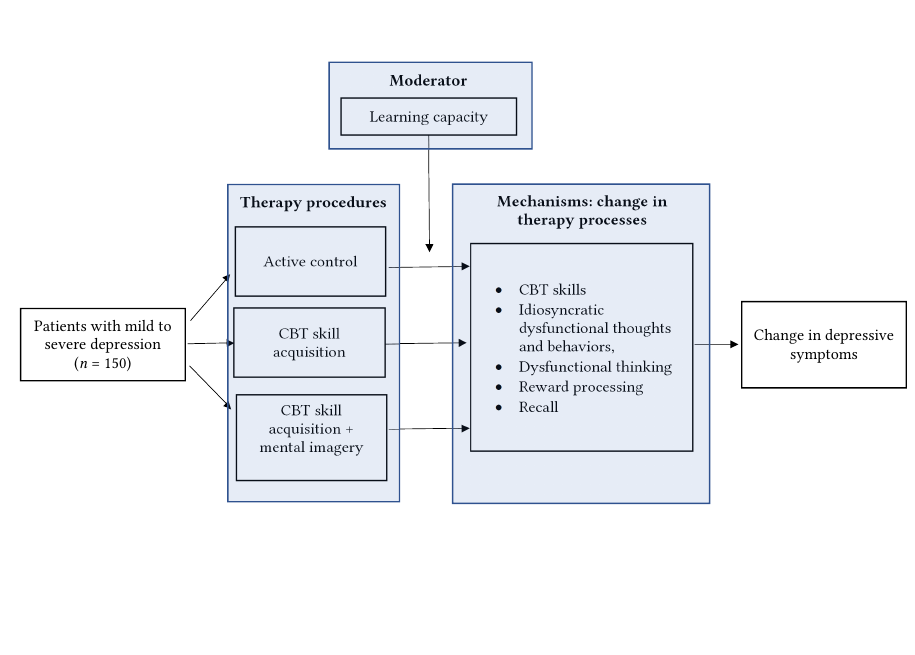
Conceptual Model for the Proposed Study